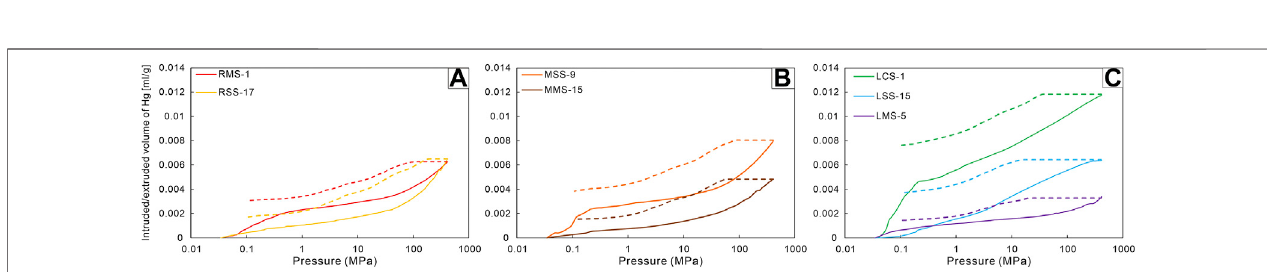
FIGURE 6 | Mercury intrusion-extrusion curves for distinct lithofacies from the Longmaxi Formation. (A) OM-rich shales; (B) OM-moderate shales; (C) OM-lean shales.